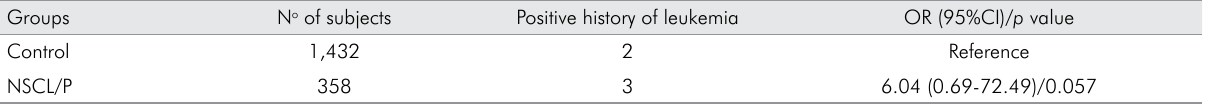
Table 1. Risk of leukemia in first-degree relatives of patients with nonsyndromic cleft lip and palate (NSCL/P)